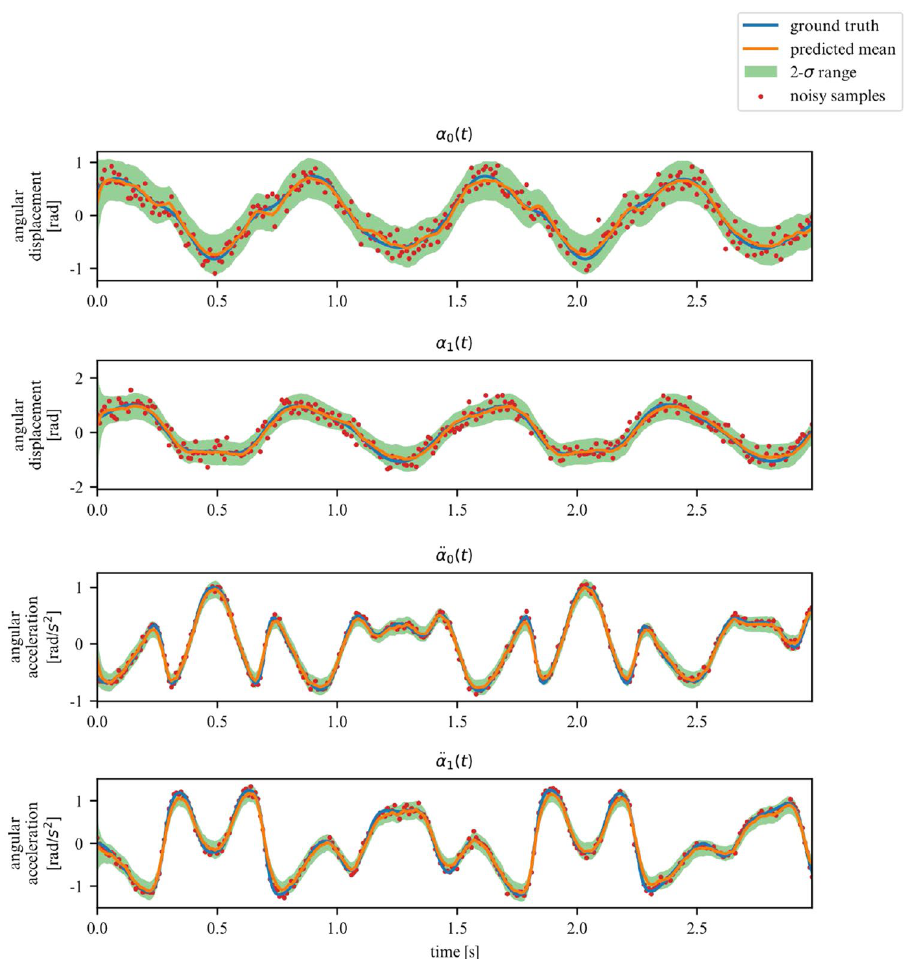
Figure 17. Double pendulum observations.